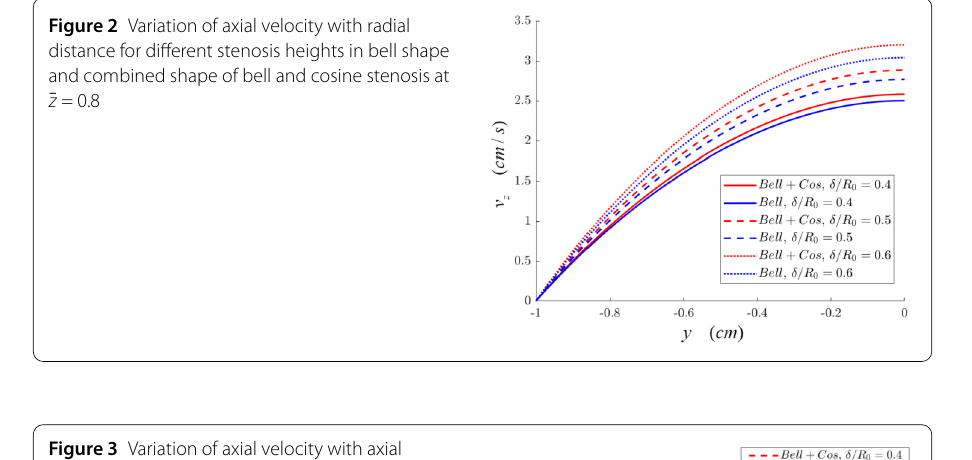
Figure 3 Variation of axial velocity with axial distance for different stenosis heights in bell shape and combined shape of bell and cosine stenosis at y = –0.5